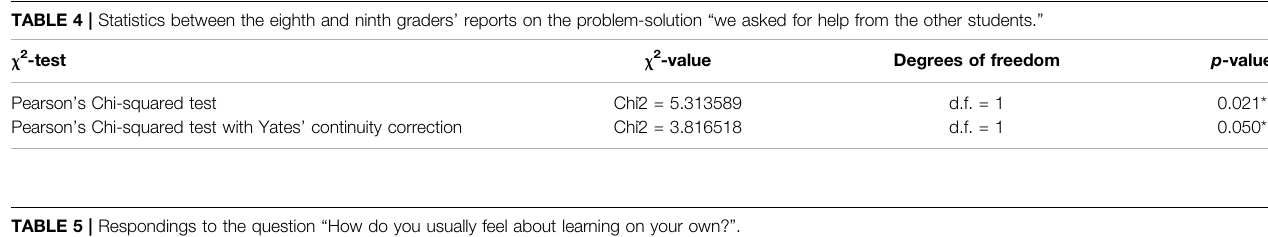
TABLE 5 | Respondings to the question “ How do you usually feel about learning on your own? ” .